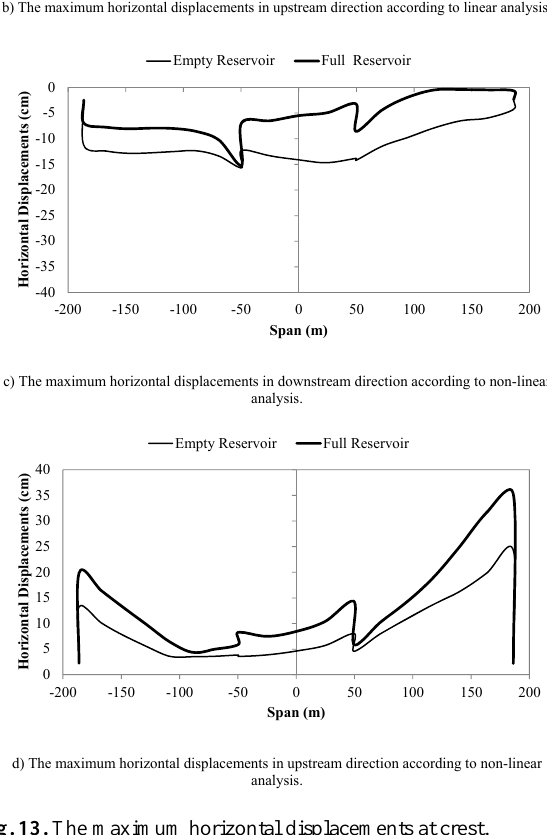
Fig. 13. The maximum horizontal displacements at crest.